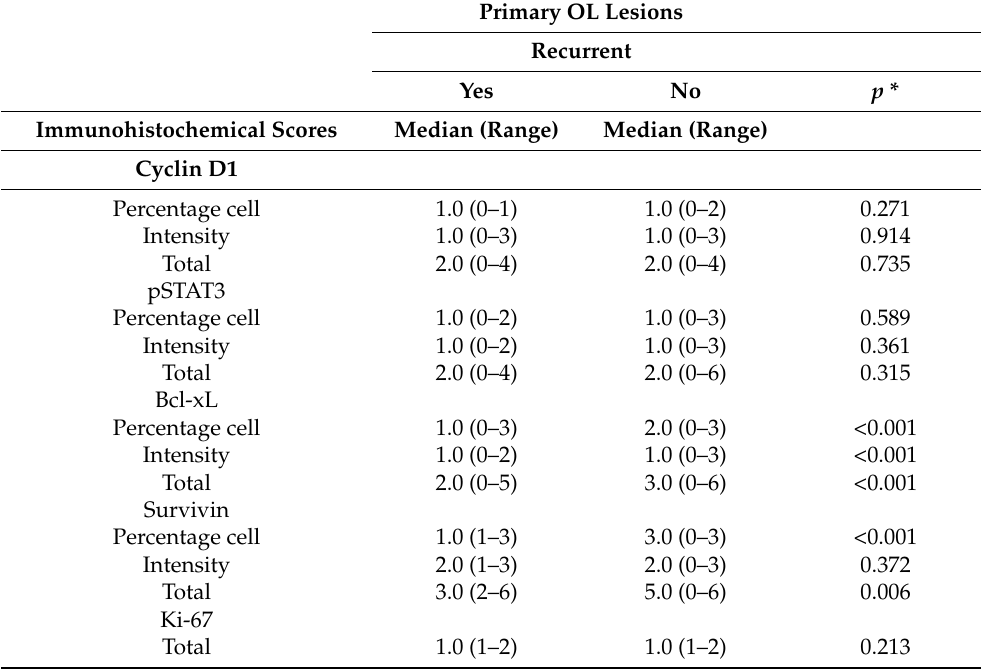
Figure 4. Comparison of mean immunohistochemical scores according to the presence and degree of dysplasia. ( A ) Cyclin D1 percentage, intensity and total scores in primary oral leukoplakia lesions (PLs), ( B ) Ki-67 total score in PLs and ( C ) Ki-67 total score in recurrences. 3.7. Comparison of IHC Expression Levels between Recurrent and Non-Recurrent Primary Lesions In order to assess the potential usefulness of the studied IHC markers as predictors of recurrence of PLs, the percentage, intensity and total scores of each molecule were compared between recurrent and non-recurrent PLs (Table 4 and Figure 5). Statistically significant differences were noticed only for Bcl-xL and survivin. Specifically, Bcl-xL received lower values in the recurrent group for percentage ( p < 0.001), intensity ( p < 0.001), and total scores ( p < 0.001). Similarly, survivin percentage ( p < 0.001) and total scores ( p = 0.006) were lower in PLs that recurred compared to non-recurrent ones. Table 4. Comparison of immunohistochemical results of various studied molecules between recurrent and non-recurrent primary oral leukoplakia (PLs) lesions.